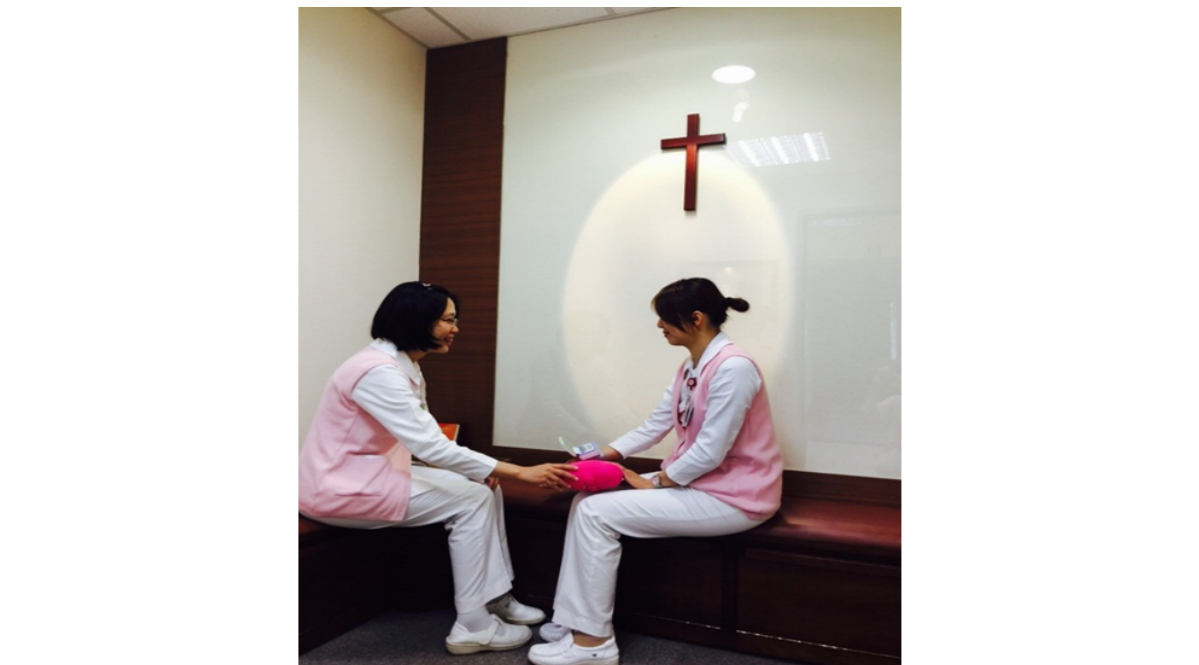
Figure 2. The experiment room setting.